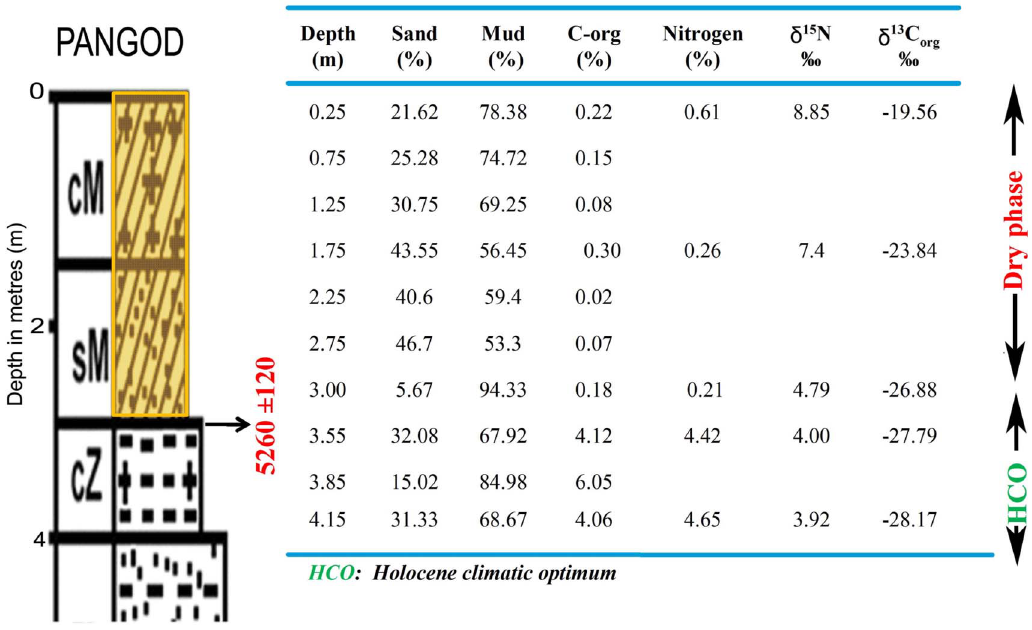
Figure 8. Sand, mud, organic carbon and nitrogen contents in the sediments of Pangod quarry along with the concentration of d 15 N and d 13 C org .